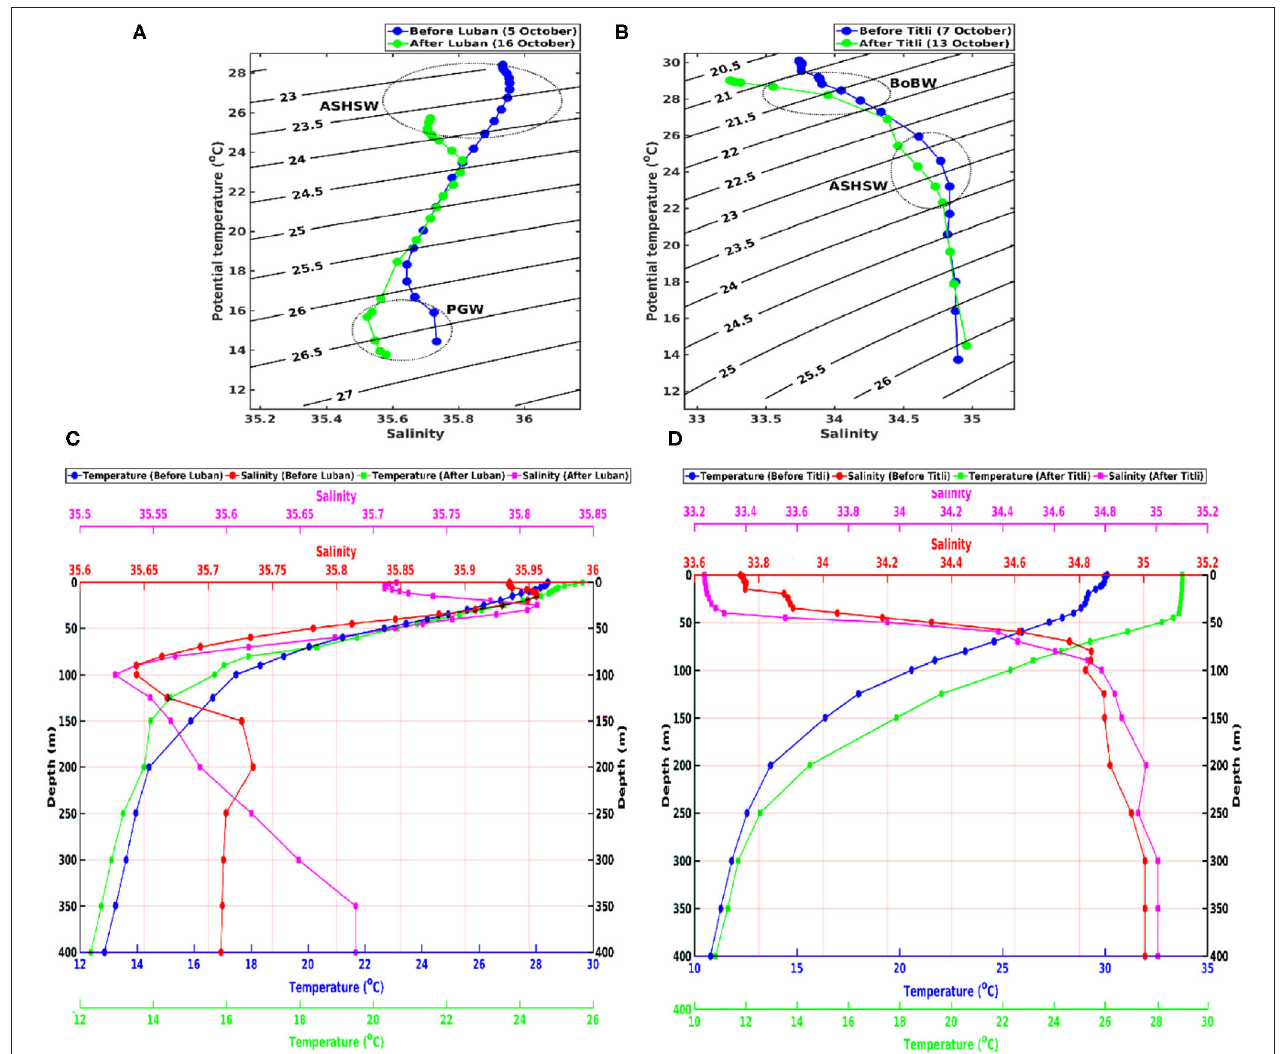
FIGURE 6 | θ -S diagram (0–200m depth) for Luban (October 5 and 16) (A) , Titli (October 7 and 13) (B) before (blue line), and after (green line) cyclones. A black solid line indicates the sigma- θ line. ASHSW, Arabian Sea High Salinity Water mass; PGW, Persian Gulf Water mass. The vertical profiles of temperature and salinity (0–400m) before and after Luban (C) and Titli (D) . Blue and green lines show the temperature profile, while red and magenta lines show the salinity profiles before and after the cyclones,